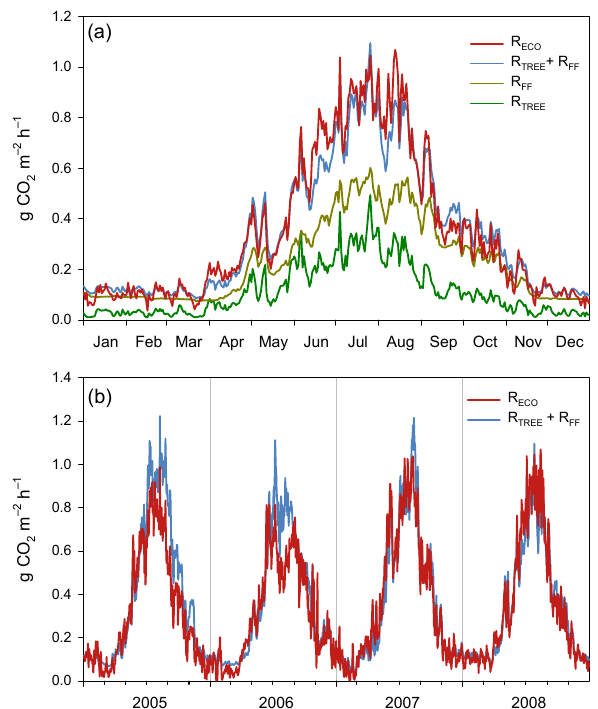
Figure 7. (a) Ecosystem respiration based on measured and gap- filled EC data ( R ECO ) and simulated respiration effluxes of dif- ferent components at Kalevansuo in 2008. Since R ECO is the total ecosystem respiration, it should equal the sum of above-ground res- piration of trees ( R TREE ) and total forest floor respiration ( R FF ) . R TREE was simulated using the SPP model, while R FF is based on measured flux data and statistical models for the same site and year. (b) R ECO compared with the sum of R TREE + R FF during the whole measurement period 2005–2008.